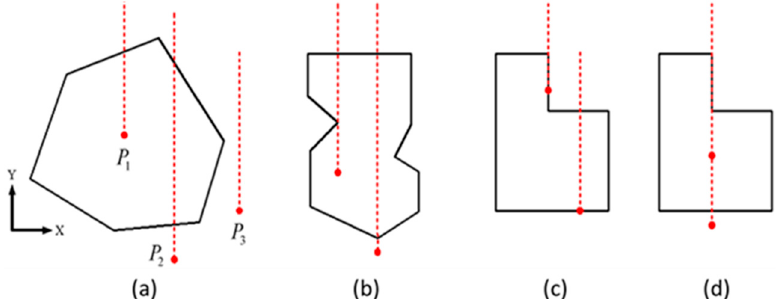
Figure 4. Point-in-polygon test by counting intersections of ray with polygon. ( a ) Only one intersection with the polygon, ( b ) ray through the vertex, ( c ) ray on the edge, and ( d ) ray coincided with the edge.